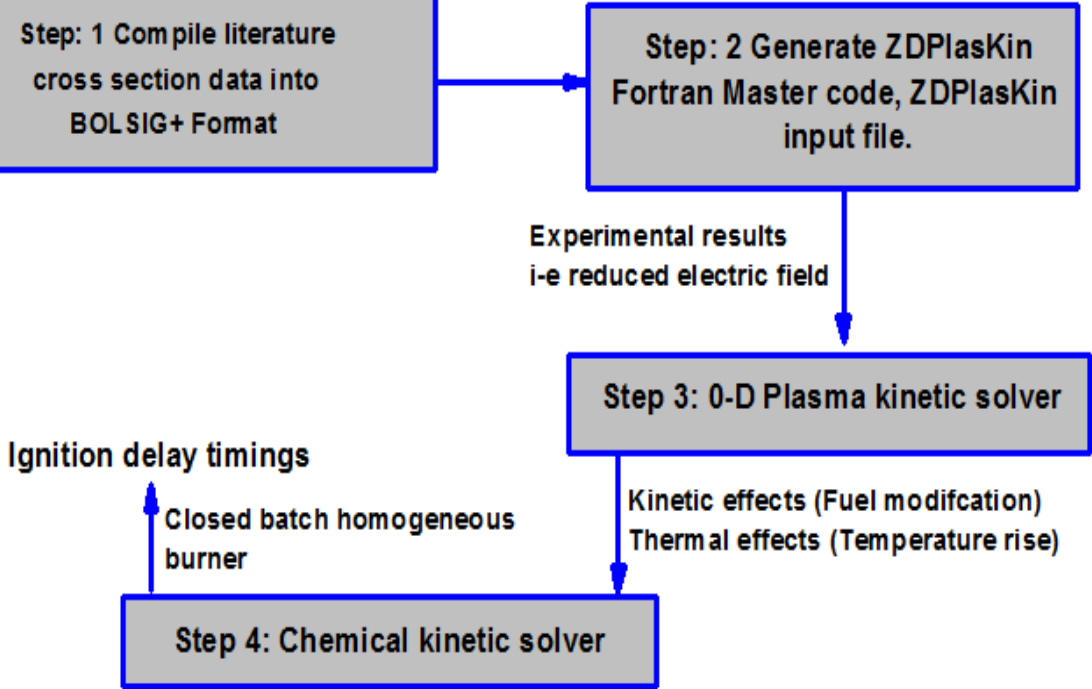
Figure 3. Detailed description of numerical methodology.